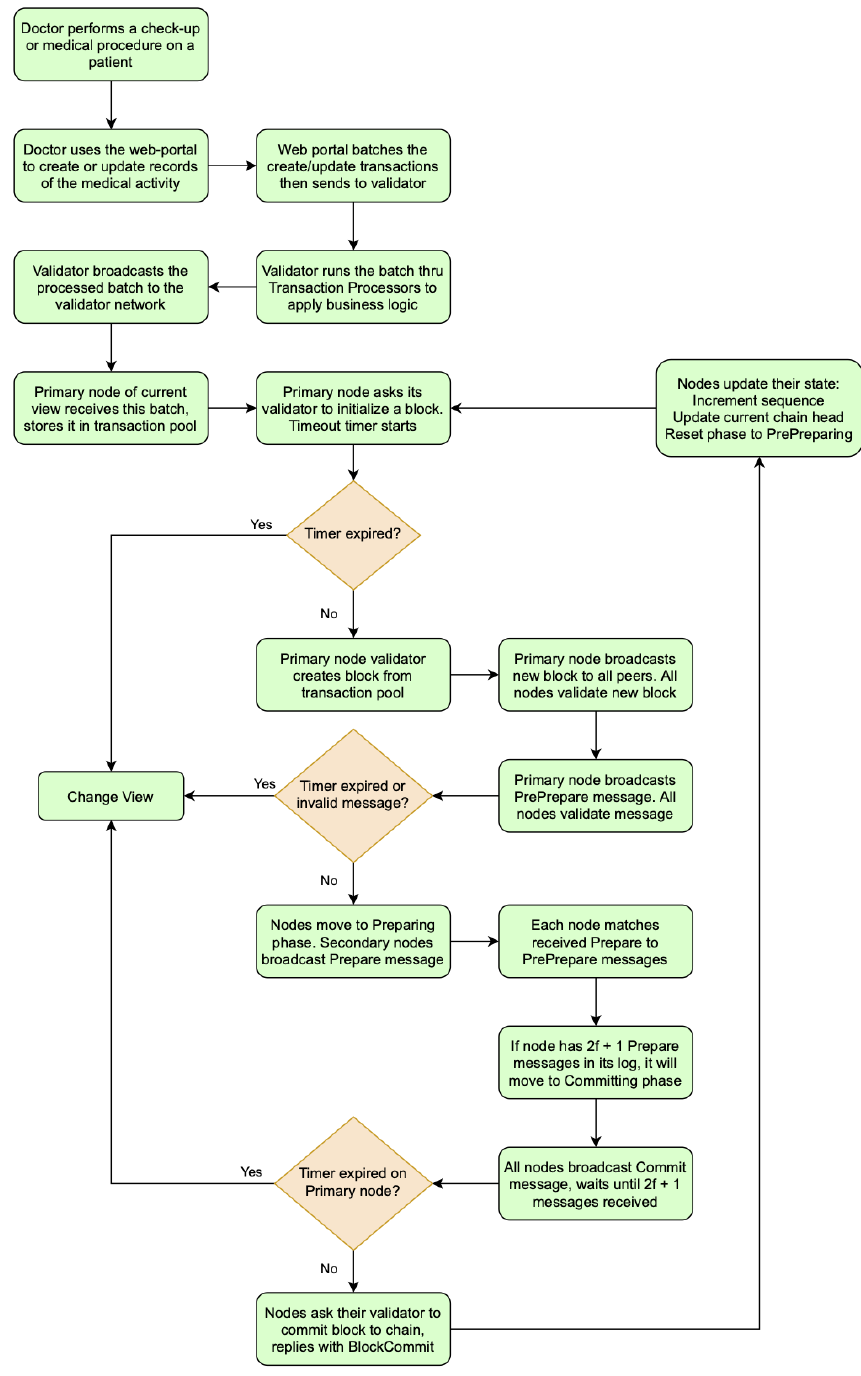
Figure 23. Hyperledger Sawtooth PBFT consensus mechanism